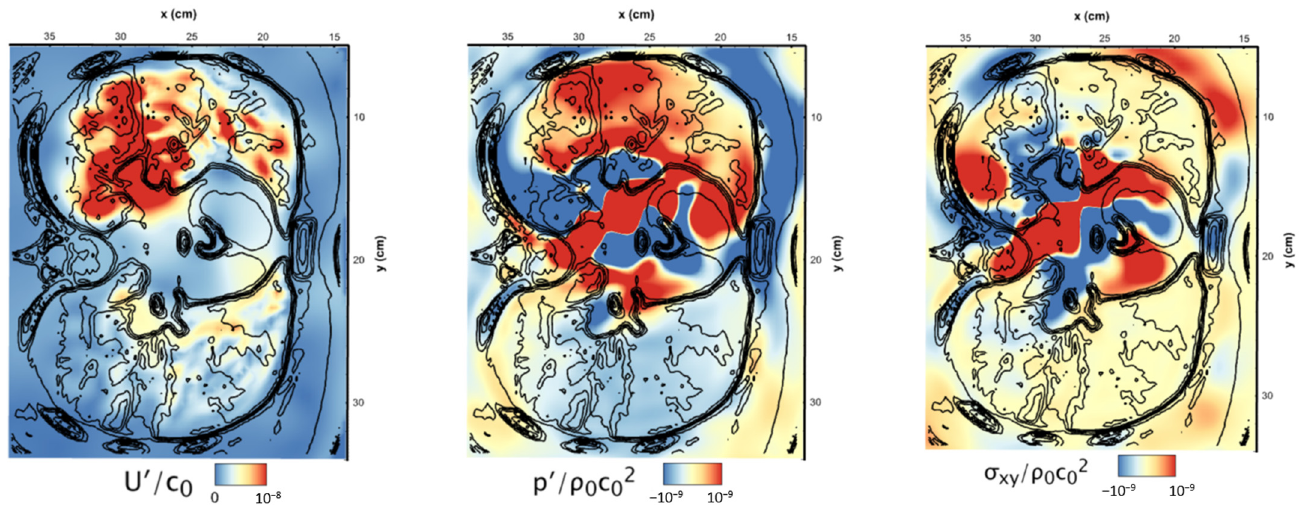
Figure 5. Instantaneous magnitude of velocity fluctuation ( 𝑈′ ), average normal stress ( 𝑃′ ), and shear stress ( σ xy ) in the moderate case at 0.105 s. Black lines are the contours of the density. ρ 0 is the density of blood. Smaller y values indicate the left-hand side of the body.